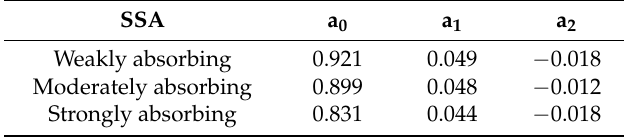
Table 10. The polynomial coefficients for the Single Scattering Albedo (SSA).